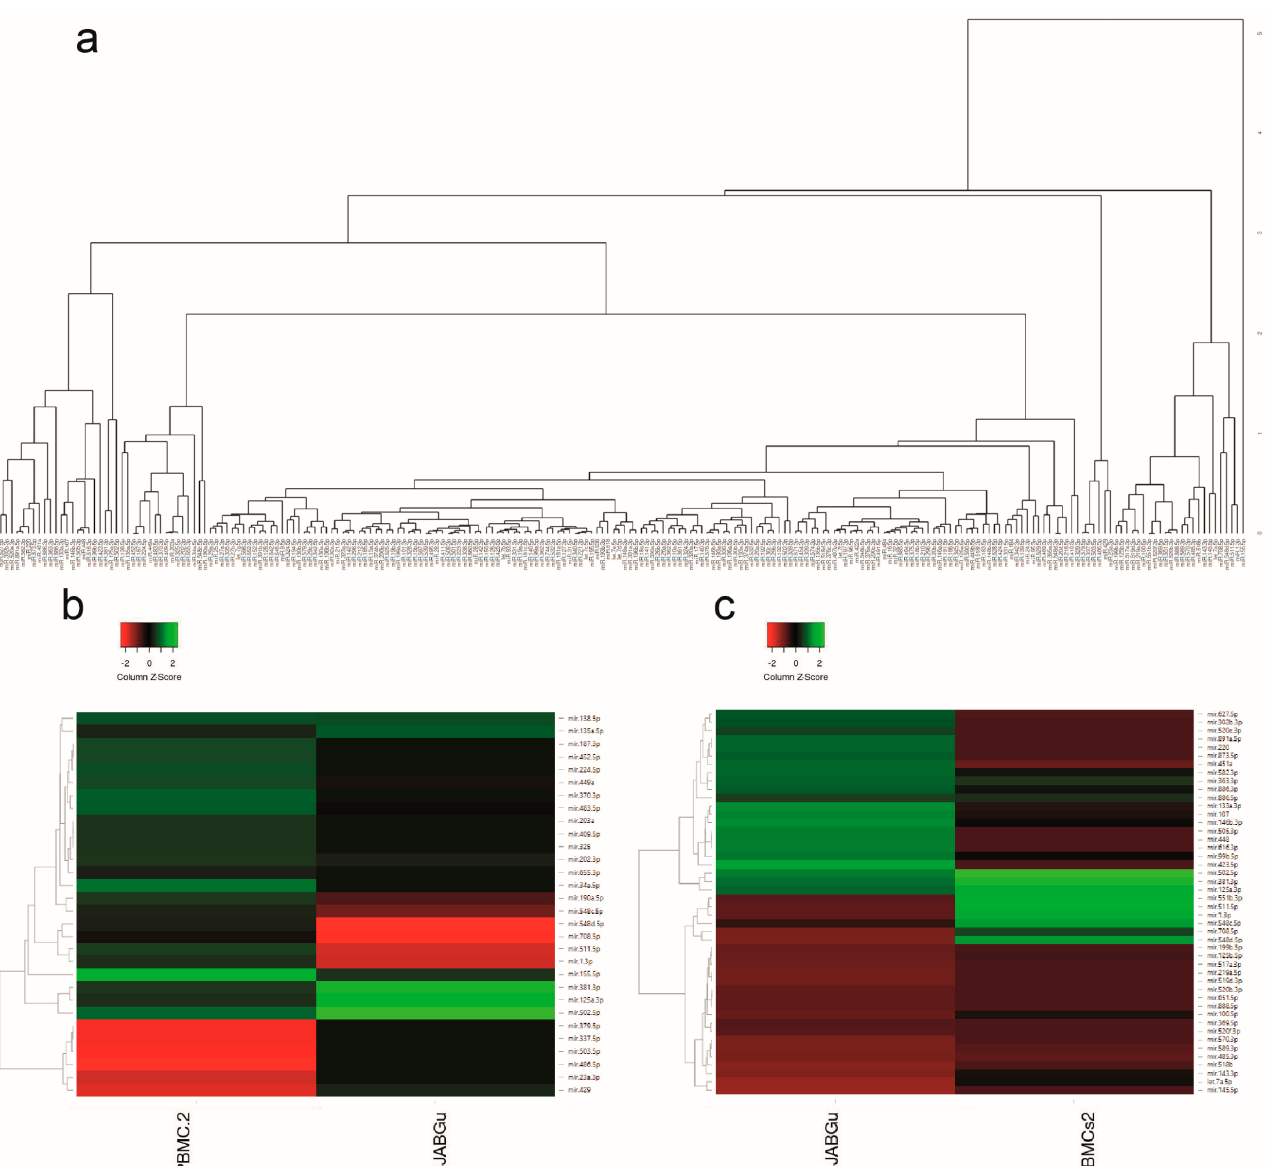
Figure 1. Dendrogram and heat maps of the differentially expressed miRNAs. ( a ) The hierarchical clustering dendrogram shows the similarities between the expression profiles of the 226 dysregulated miRNAs. ( b ) The heat map of miRNAs whose expression levels varied by at least 1 log10 (fold change (FC)) in HTLV-2-infected PBMCs (first column) and profile of corresponding miRNAs altered in BJABGu (second column). ( c ) The heat map of miRNAs with [log10 (FC) > |1|] in BJABGu (first column) and the profile with miRNAs modulated in the HTLV-2-infected PBMCs (second column). Each colored block represents the expression of 1 miRNA (labeled on the right) in the indicated sample. PCR expression signals are converted into color (green, high signal; red, low signal). Color intensities are proportional to the variation of expression, as indicated in the scale bar: values ranged from − 2 to + 2 (z score).